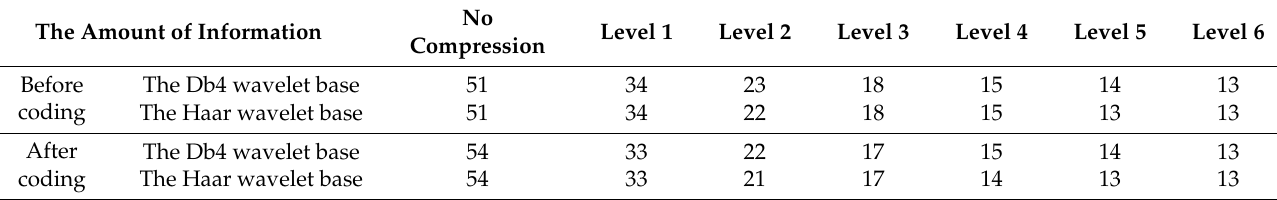
Table 1. Changes in the Amount of Huffman Coding Information